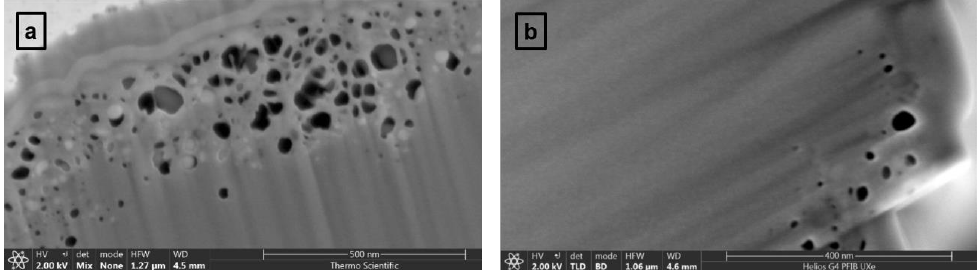
Figure 3. ( a , b ) High resolution SEM images of samples 2 and 3 enabling visualization of nanoscale defects near CF surfaces.